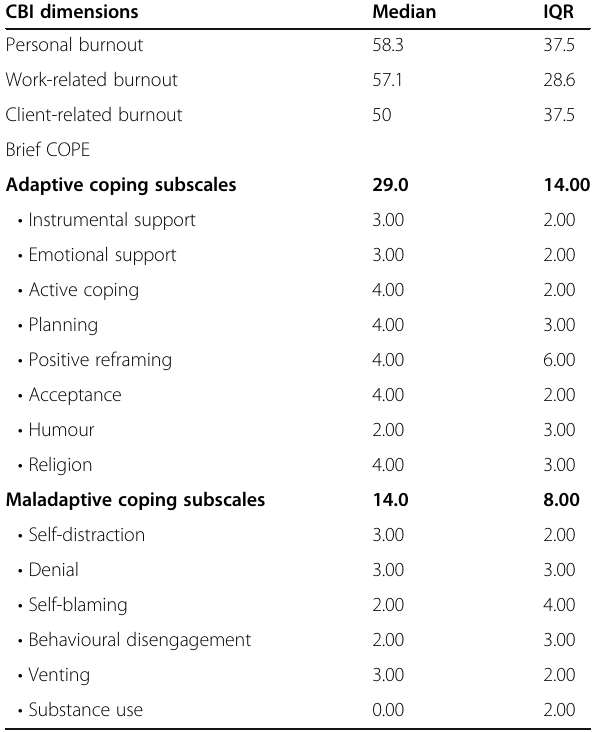
Table 1 Descriptive statistics of CBI and Brief COPE ( n = 403)